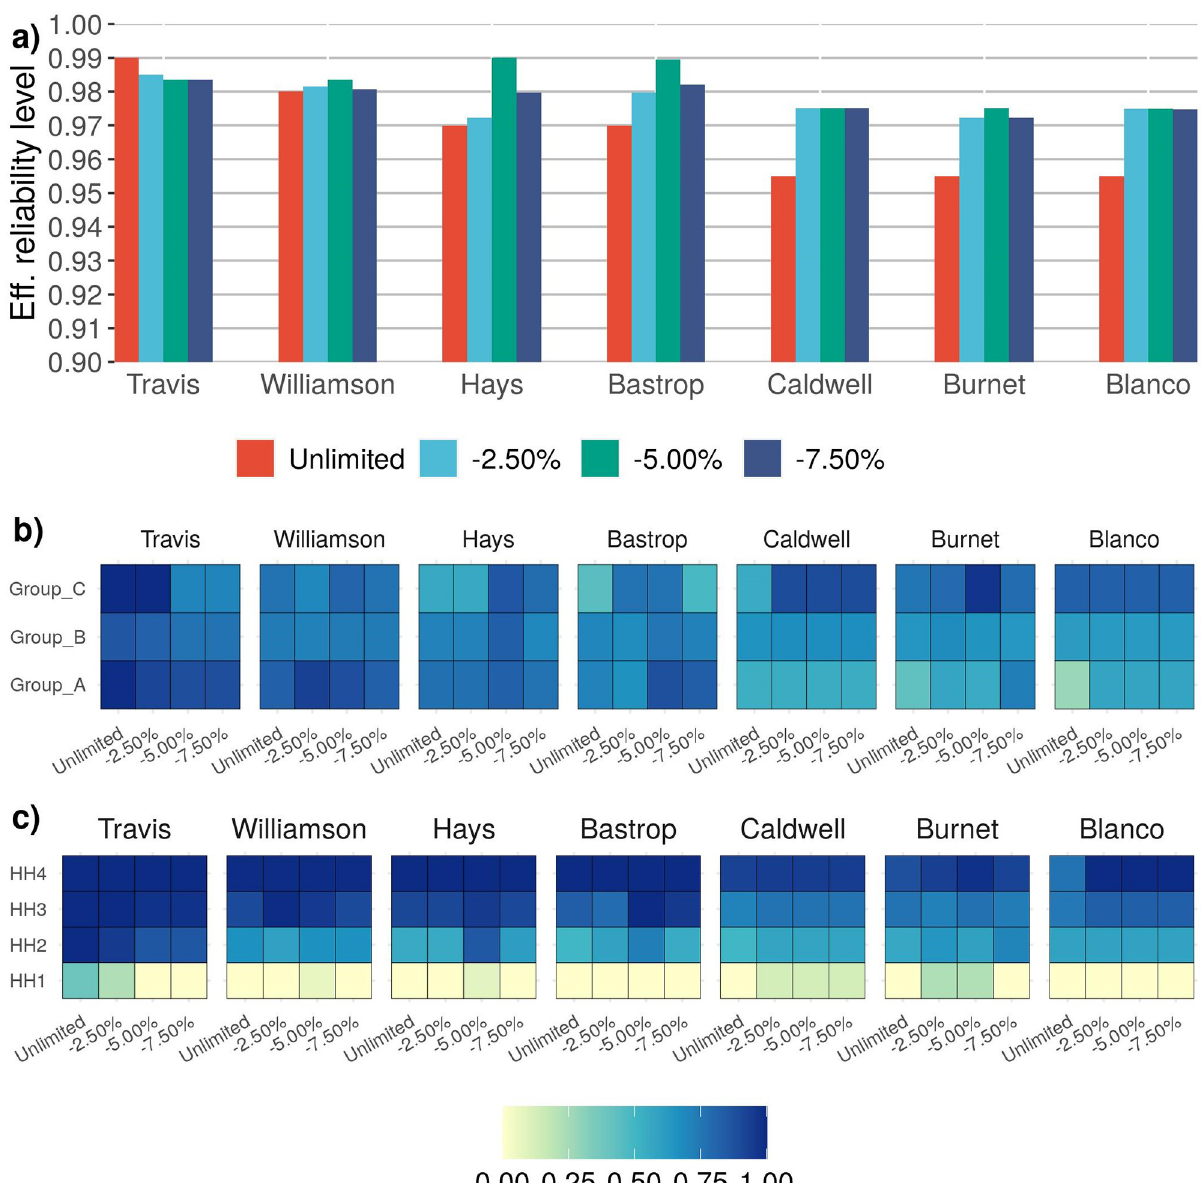
Fig 5. This figure illustrates the reliability adjustment and vaccine sharing capability prescribed by the heterogeneous model under infectivity Case 2, limited vaccine availability and High reliability level. a) The bar-plot illustrates that reliability adjustment feature of the heterogeneous model under limited vaccination. For Unlimited vaccine availability the model achieves the required High reliability but as the vaccine availability reduces the reliability levels are adjusted to achieve an optimal vaccination policy. Generally, Travis county reliability is reduced and for other counties reliability is increased. b) For each county, the heatmap illustrates proportion of population to be vaccinated within an age group for a case of vaccine availability. Across all the counties there is no clear pattern but the plot shows the vaccination policy per age group within a county. c) For each county, the heatmap illustrates proportion of population to be vaccinated within a household size for a case of vaccine availability. It shows that for Case 2 of infectivity if the reliability is lowered and vaccines are released from a county and assigned to counties where additional reliability is achieved, generally vaccines are first released from HH1 followed by HH2. And the counties receiving these additional vaccines assign them to higher household size of three and four.